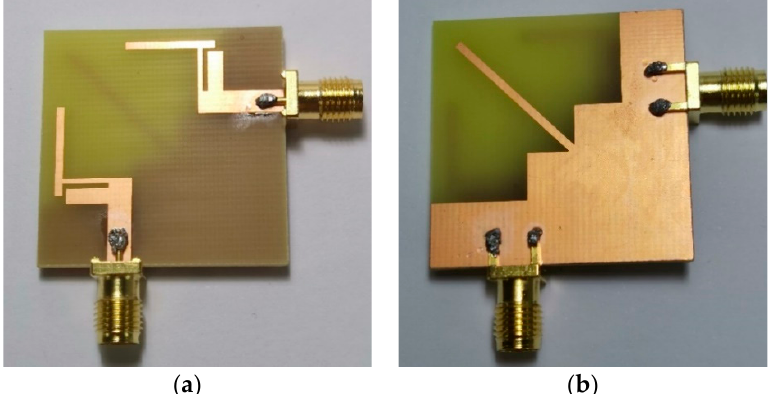
Figure 2. Photograph of the fabricated antenna prototype ( a ) top view; ( b ) bottom